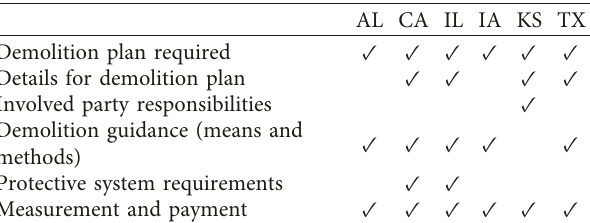
Figure 6: Information or resources beneficial for agency. Table 1: Contents of guidelines